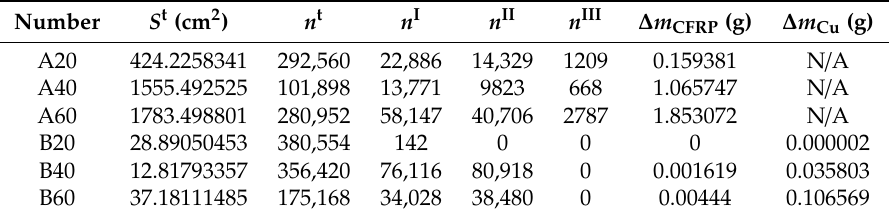
Figure 10. Di ff erent areas of tomography images’ summaries of A20: ( a ) Area I; ( b ) Area II; ( c ) Area III. Results of pixel statistics and ablation mass losses obtained by Equations (2)–(4) are shown in Table 5. Table 5. Results of pixel statistics and ablation mass losses. S t is the total area; n t is the total number of pixels; n I , n II , and n III are, respectively, the total pixels’ number of Area I, Area II, and Area III; ∆ m CFRP and ∆ m Cu are, respectively, the ablation mass losses of CFRP and copper